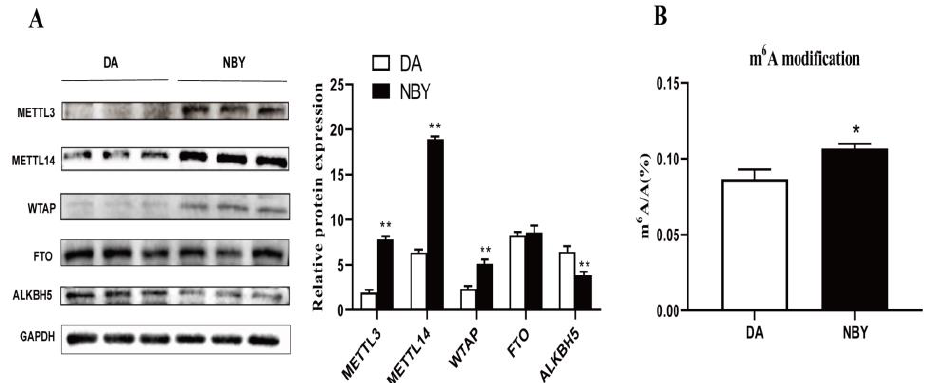
Figure 1. Protein expression of m6A-related enzymes in DA and NBY LD and detection of global m6A levels. ( A ) The expression of METTL3, METTL14, WTAP, FTO and ALKBH5 protein abundance was detected by Western blot (** p < 0.01). ( B ) M6A/A ratio of DA and NBY samples were measured by LC-MS/MS. The bar shows the mean from n = 3 sample replicates (* p < 0.05).